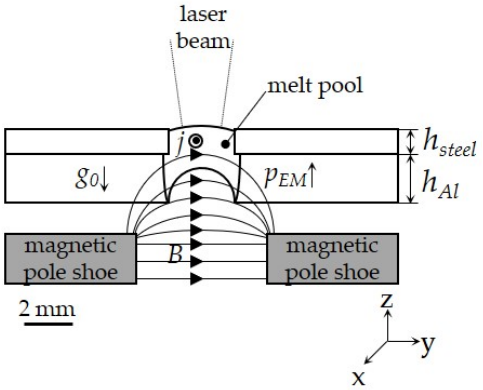
Figure 2. The controlled displacement of the laser beam-induced melt.